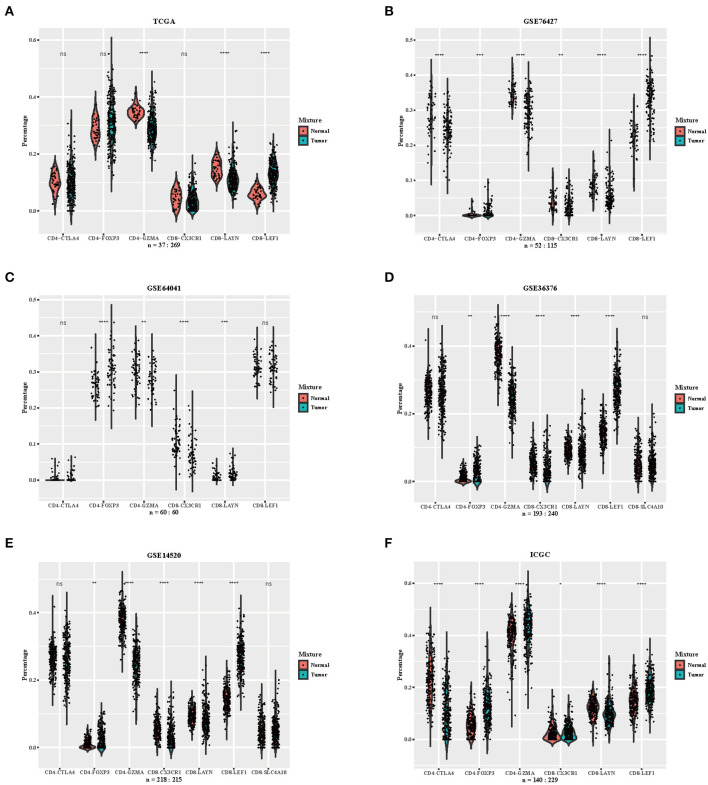
Distribution of inferred immune cell subsets in various datasets. (A–F) Violin plots depicting the different distributions of several immune cell subsets between tumor and normal samples from datasets TCGA, GSE76427, GSE64041, GSE36376, GSE14520, and ICGC (Immune cell subsets with low proportions were excluded, depicted p-values are from Wilcoxon test). ns, not significant; *p < 0.05; **p < 0.01; ***p < 0.001; ****p < 0.0001.